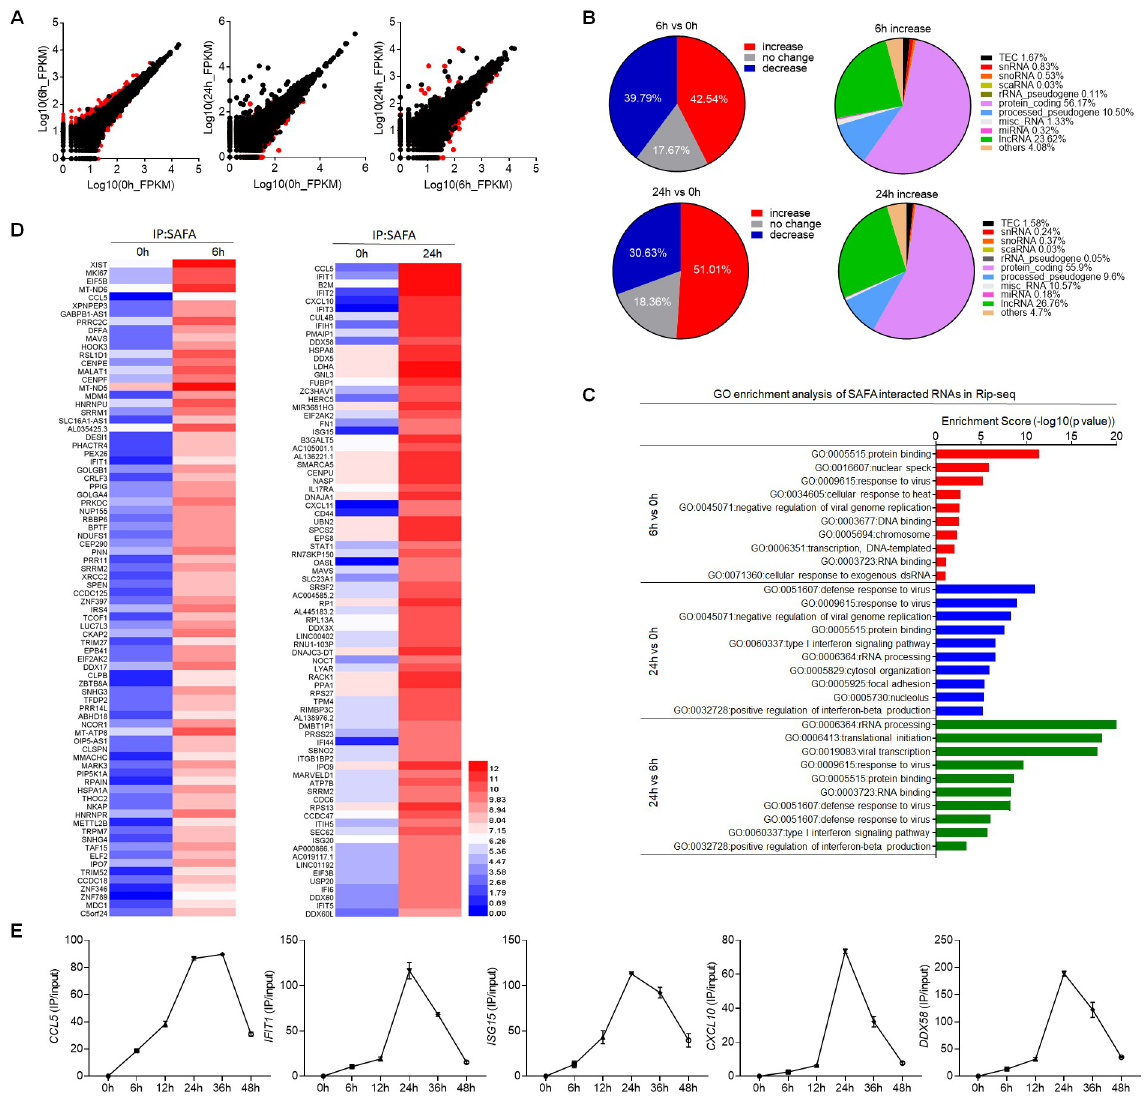
Fig 4. SAFA interacted with antiviral related RNAs in a time-dependent manner during viral infection. (A) Scatter diagram showing differential RNA binding profiles of SAFA in THP-1 cells with VSV infection for 6 hours or 24 hours. (B) Pie chart showing the changes of RNAs interacted with SAFA in RIP-seq upon VSV infection (left); pie chart showing the distribution profile of RNAs with increased interaction with SAFA after VSV infection (right). (C) GO term enrichment analysis of RNAs interacted with SAFA in RIP-seq. (D) Heatmap (log RPKM +1) showing RIP-seq signal for the indicated RNAs. (E) Line graph showing time-dependent RNA binding manner of indicated genes with VSV infection for indicated times. The cells were infected by VSV at 0.1 MOI. Data were pooled from two independent experiments (A-D). Data were pooled from three experiments